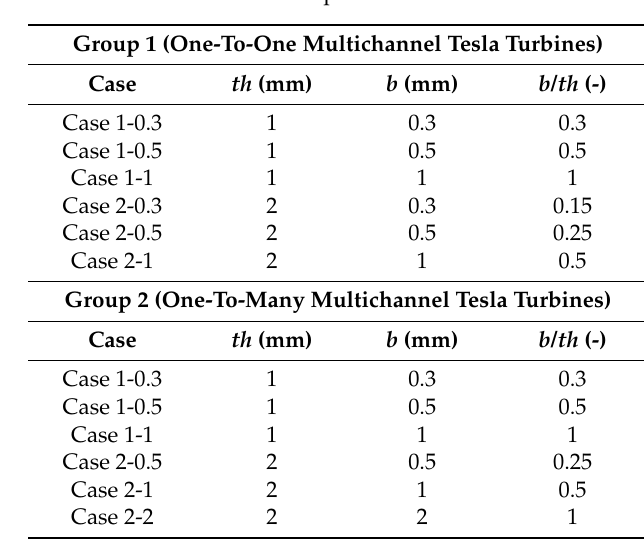
Table 1. Geometrical parameters of each